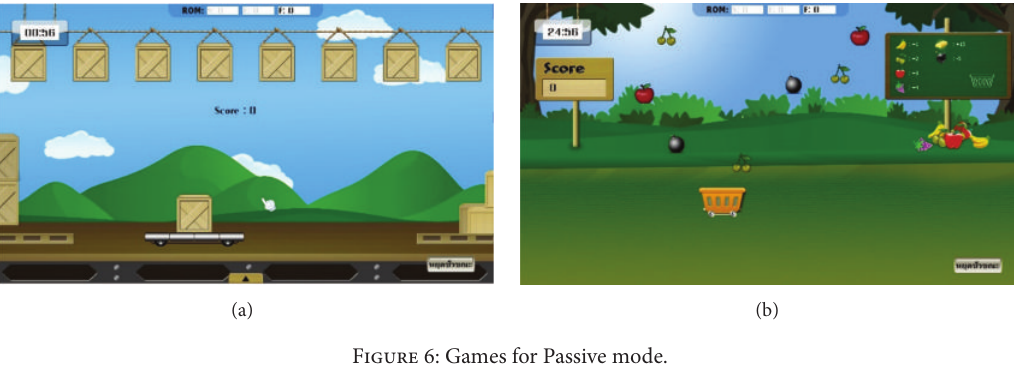
Figure 6: Games for Passive mode.